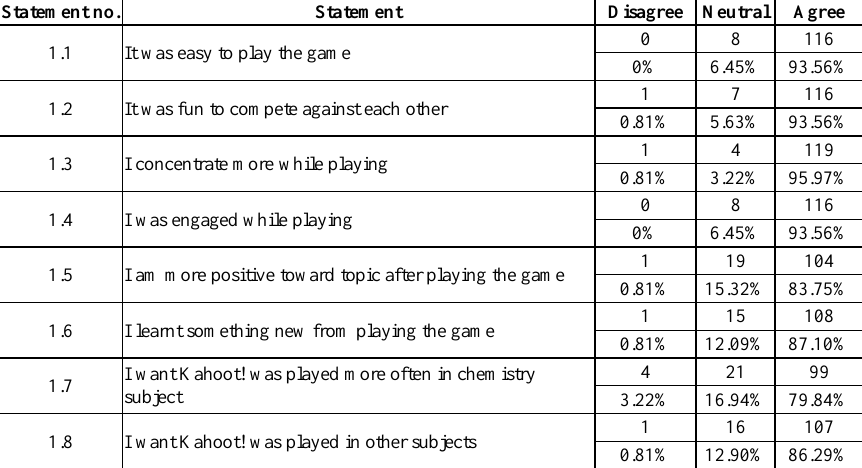
Table 5. Questionnaire Result, Part 1